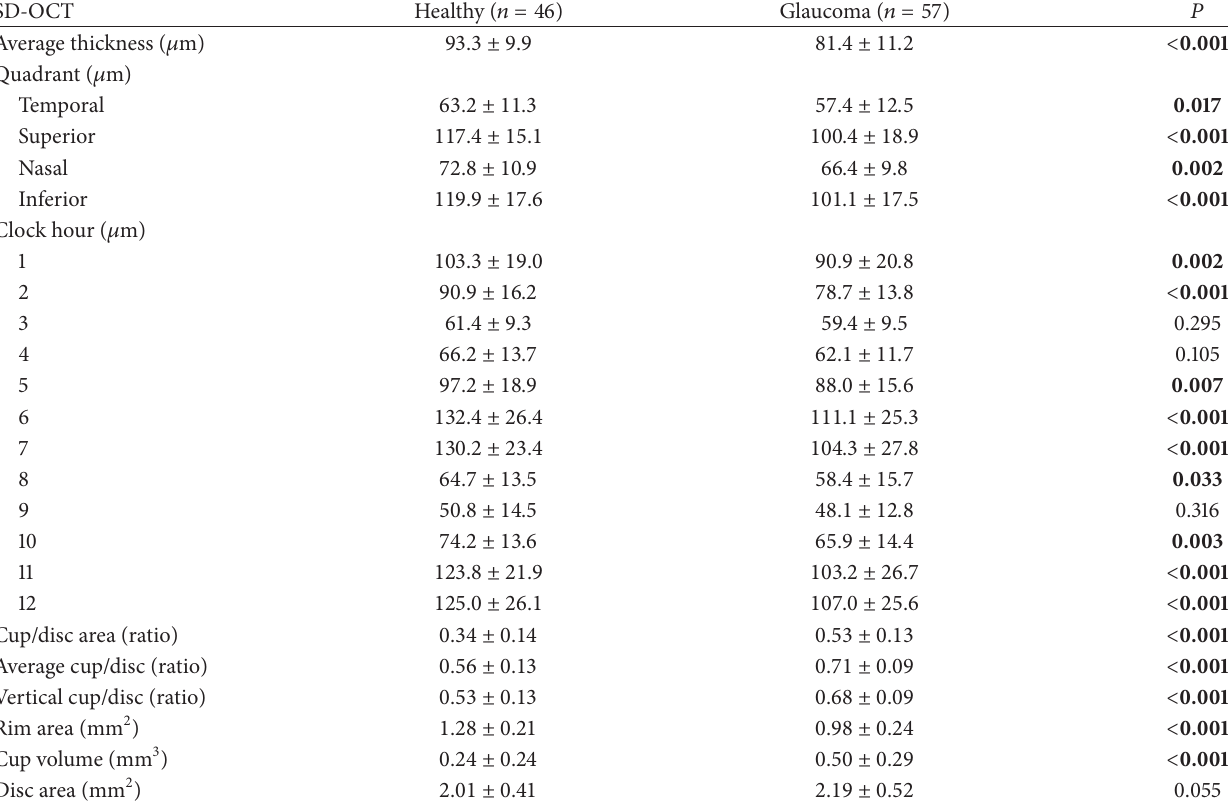
Table 2: Mean ± standard deviation of SD-OCT parameters in both